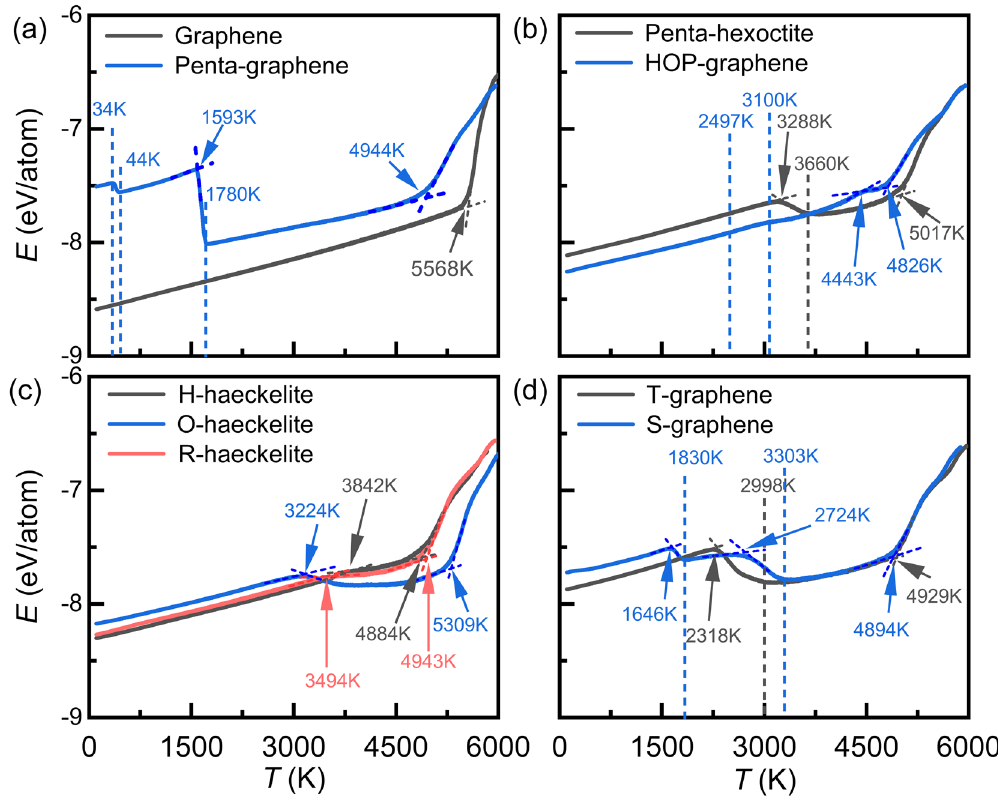
Figure 2: Variations in the potential energy ( E ) per atom with temperature for 2D carbon crystals of ( a ) graphene and penta - graphene; ( b ) penta - hexoctite and HOP - graphene; ( c ) H - , O - , and R - haeckelites; and ( d ) T - graphene and S - graphene,